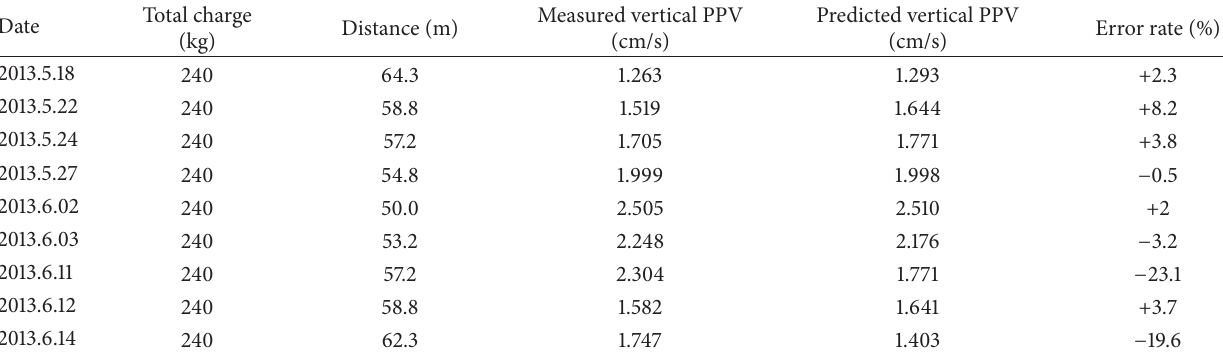
Table 5: The simulation and monitoring data of blasting vibration.